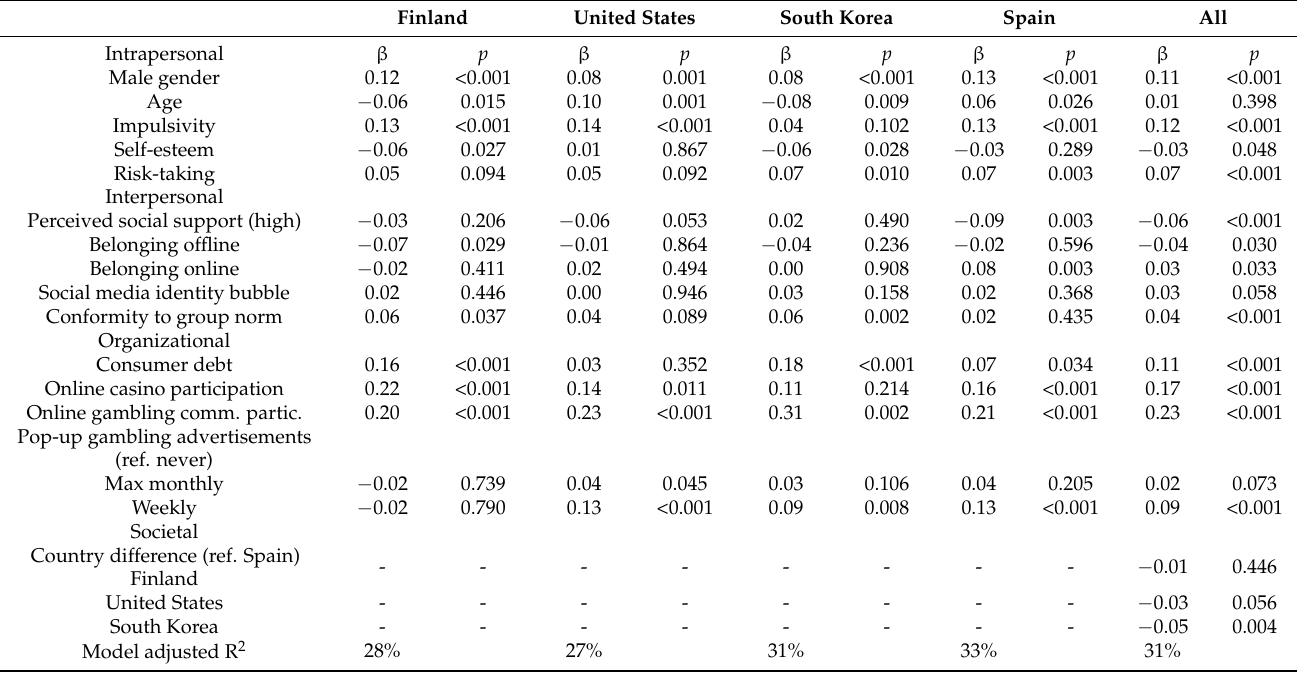
Table 3. Problem gambling explained by the full social ecological model in linear regression models. Finland United States South Korea Spain